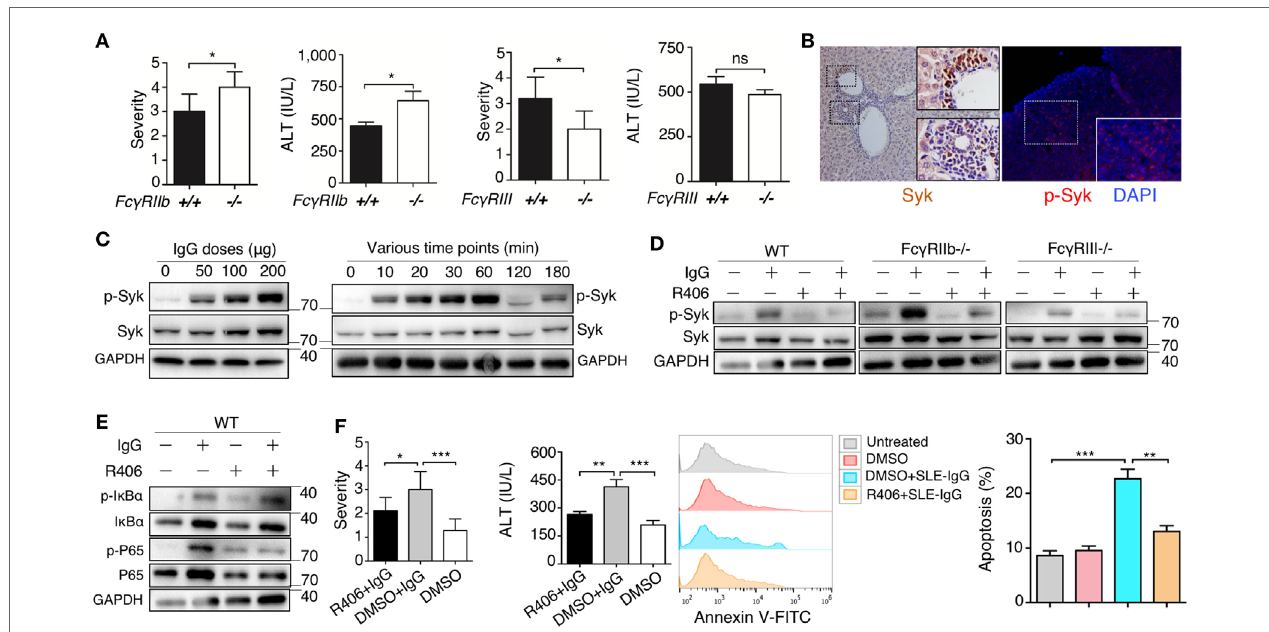
FigUre 5 | Spleen tyrosine kinase (Syk) inhibitor suppressed liver inflammation induced by deposited lupus immunoglobulin G (IgG). (a) Severity of liver inflammation and serum alanine aminotransferase (ALT) level 48 h after intrahepatic injection of systemic lupus erythematosus (SLE)-IgG in mice with Fc γ RIIb- deficient (Fc γ RIIb − / − ) and Fc γ RIII-deficient (Fc γ RIII − / − ). * p < 0.05 (the result is representative of three independent experiments, n = 6 mice per group/experiment). (B) Representative image of Syk and p-Syk expression in inflamed liver sections from lupus-prone mice (aged 29 weeks) by immunohistochemistry and immunofluorescence, respectively. (c) Western Blot detected phosphorylation of Syk (p-Syk) or Syk in BMDMs stimulated by various doses of SLE-IgG for 30 min or stimulated by SLE-IgG (100 µg/ml) for the indicated time points as shown. BMDMs (2 × 10 6 cells) were isolated from wild-type (WT) mice. The results were from three independent experiments. (D) Western blot analyzing p-Syk or Syk in BMDMs stimulated by 100 µg/ml SLE-IgG in presence or absence of Syk inhibitor R406 (2 µM) for 30 min. BMDMs (2 × 10 6 cells) were isolated from WT or Fc γ R − / − mice. The results are from three independent experiments. (e) WT-derived BMDMs (2 × 10 6 cells) were stimulated with 100 µg/ml SLE-IgG in the presence or absence of Syk inhibitor R406 (2 µM) for 30 min. Cell lysates were subjected to immunoblotting analysis to detect the designated proteins or their phosphorylated cognates. (F) The severity of liver inflammation, serum ALT level, and analysis of apoptotic hepatocytes in C57BL/6 mice treated with or without Syk inhibitor R406 (10 mg/kg body) sacrificed 48 h after intrahepatic injection of SLE-IgG (200 µg) from a patient with lupus. * p < 0.05, ** p < 0.01, *** p < 0.001 (the result is representative of three independent experiments, n = 7 mice per